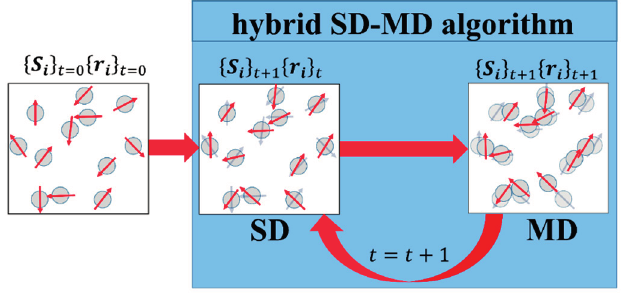
Figure 4. Schematic representation of the hybrid algorithm that couples spin dynamics (SD) and molecular dynamics (MD) simulations in order to calculate trajectories of magnetic nanoparticles that interact via magnetic dipole-dipole interaction. Starting from a